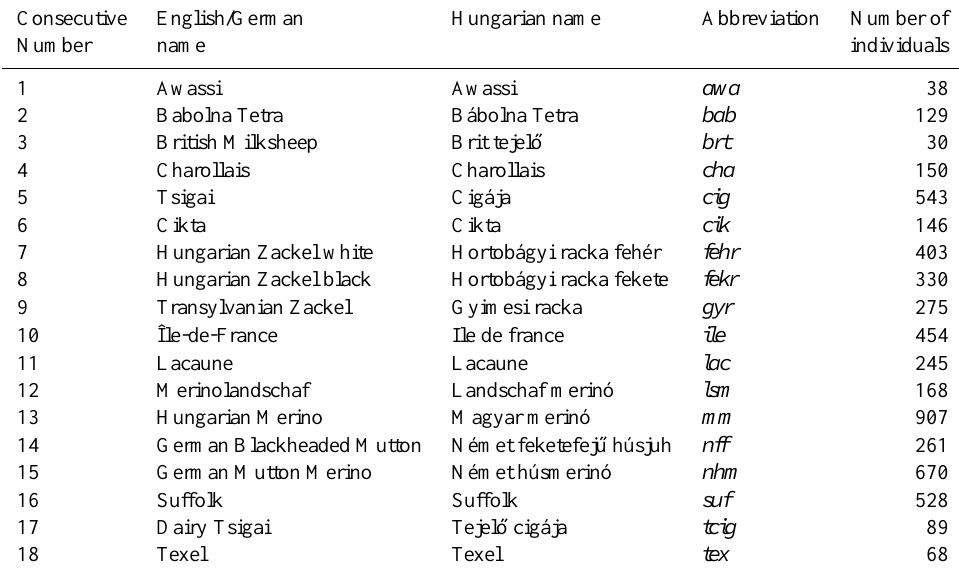
Table 1. Details on the 18 sheep breeds: the consecutive number (used for the illustrations), the English and Hungarian names, abbreviations, and numbers of individuals (after data